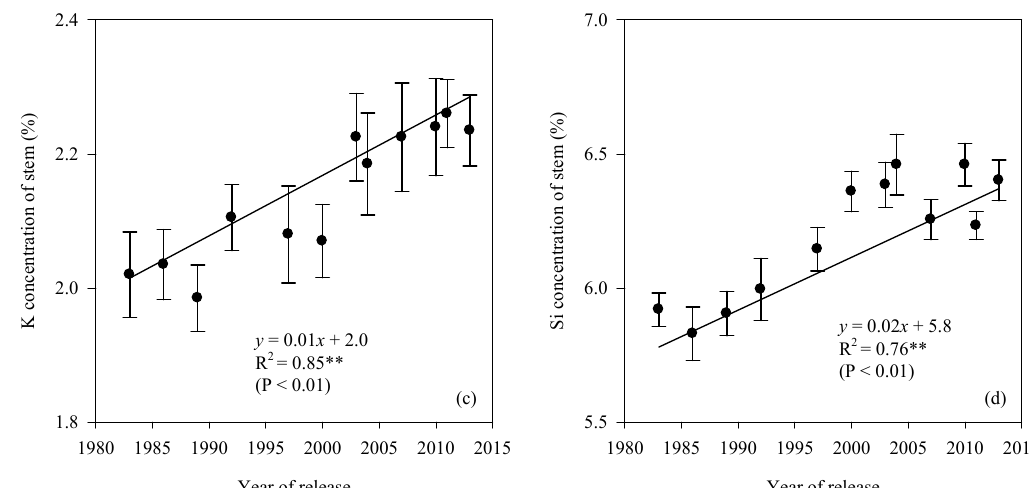
Figure 9. Relationships between year of release and stem weight per tiller at heading and maturity ( a , b ) and K and Si concentrations of stem at maturity ( c , d ) of rice cultivars. Data were fitted by linear regression ( y = a x + b). In the linear regression, x was reassigned as years after 1983; for example, x was valued as 1 in 1983 and so on. **, significant at the 0.01 probability level according to the LSD test. Vertical bars represent ± standard error of the mean ( n = 6).